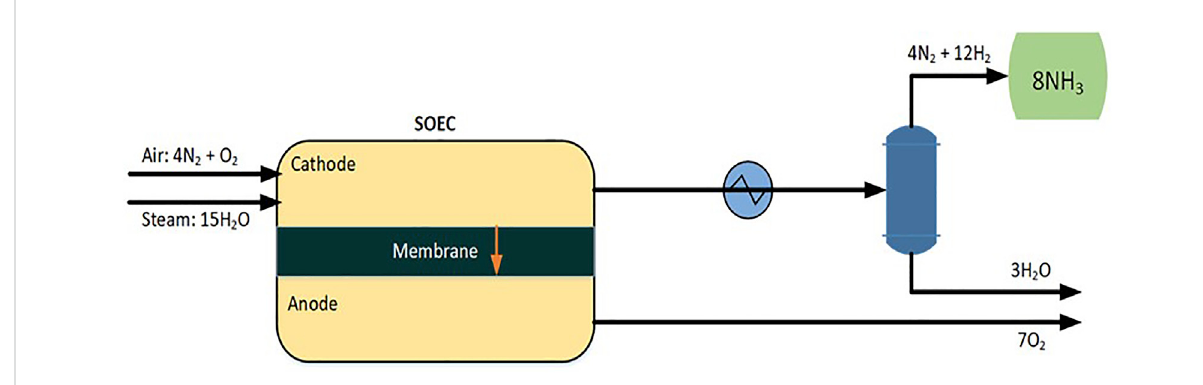
FIGURE 4 Haldor topsoe SOEC technology model with downstream exothermal Haber-Bosch reactor. Source: Adapted from Ghiyati (Ghiyati, 2021a).